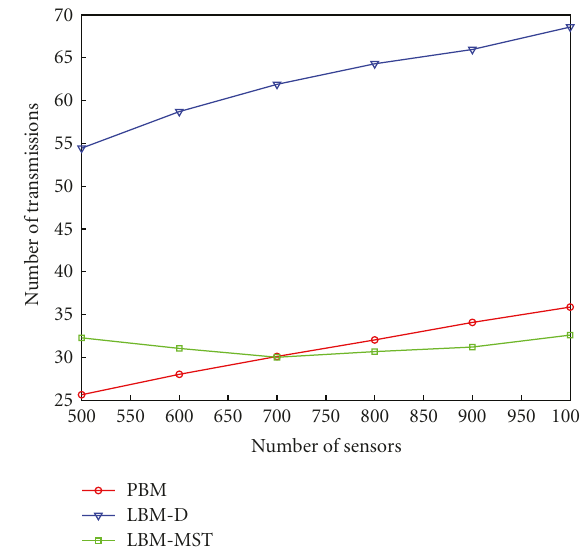
Figure 11: Average end-to-end delay for separately distributed destinations.